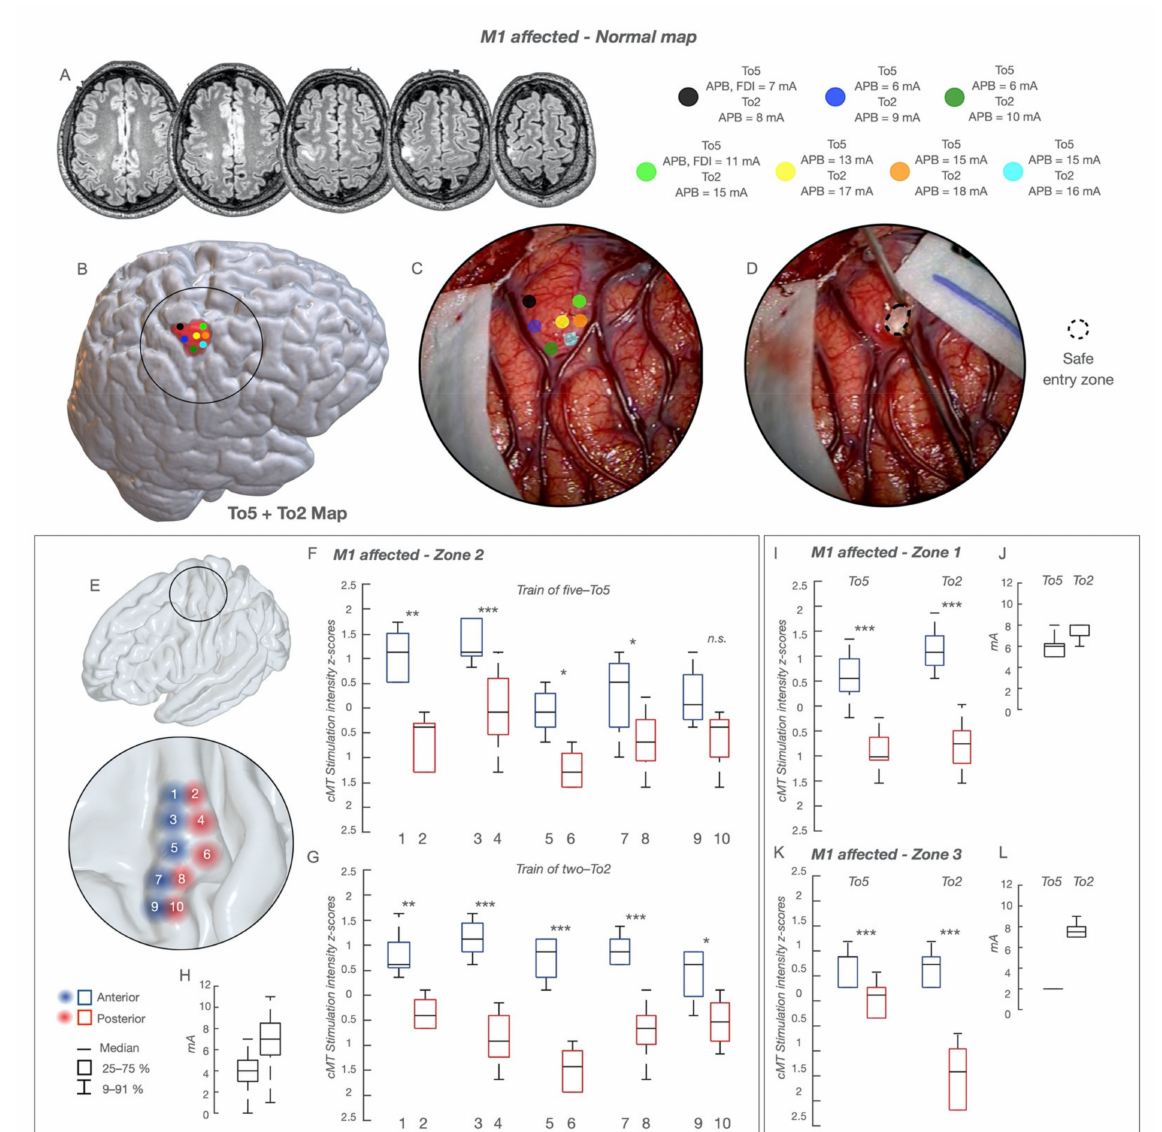
Figure 3. “Normal” functional cortical map in the group of 66 patients with tumors within M1. The functional cortical map is presented in a representative case of glioma involving the non-dominant hand-knob; the lesion is visible in ( A ), sequential axial FLAIR images, as a poorly defined mass (low-grade glioma) involving the hand-knob region of M1. The cortical area exposed (circle line), the sites stimulated with HF-To5 and HF-To2 (colored dots) and the tumor area (pink volume) are reconstructed in an NMI space and shown in ( B ). The picture of the intraoperative field along with the location of the stimulated sites (colored dots) superimposed to the surgical field is shown in ( C ). The entry point where the resection was started is shown in ( D ) as a dotted circle. For each dot, the cMT (quantitative parameter) at HF-To5 and HF-To2 and the pattern of muscle activated (qualitative parameters) are reported; when the same sites were stimulated with HF-To2, only APB MEPs were evoked at the anterior bank (cMT 15–17 mA) and at the posterior one (cMT 8–10 mA). A clear functional segregation was documented between the anterior (lower excitability) and posterior (higher excitability) regions. The safe entry zone ( D ) corresponded to the area of lower excitability. ( E ) The hand-knob region was divided based on 10 stimulated sites (1,3,5,7,9 covering the anterior region—red circles; 2,4,6,8,10 covering the posterior region—blue circles); in each site the cMT (absolute value, mA) at HF-To5 ( F ) and HF-To2 ( G ) was normalized within the subject ( Z -score) to allow for a comparison between the anterior and posterior regions with each paradigm. The same procedure was applied for the other body division, lower limb (zone-1) ( I ) and face (zone-3) ( K ). cMT are expressed as 25–75% median (rectangle) and 9–91% (edge of the box), along with the delta ( H , J , L ); * p < 0.5; ** p < 0.01; *** p <